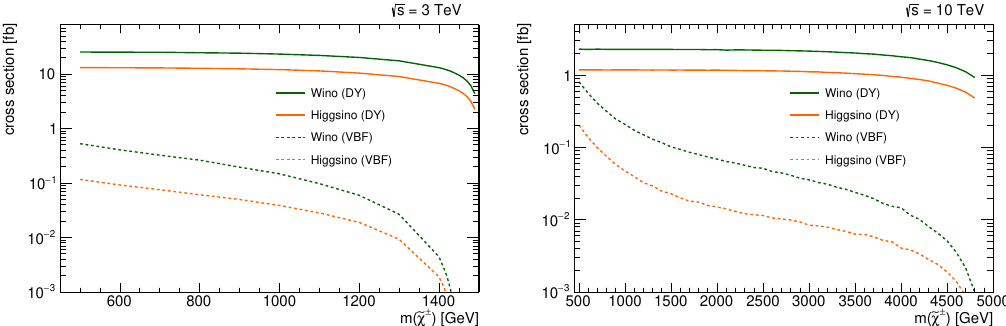
√ s = 3(10) TeV, in the left (right) panel. We